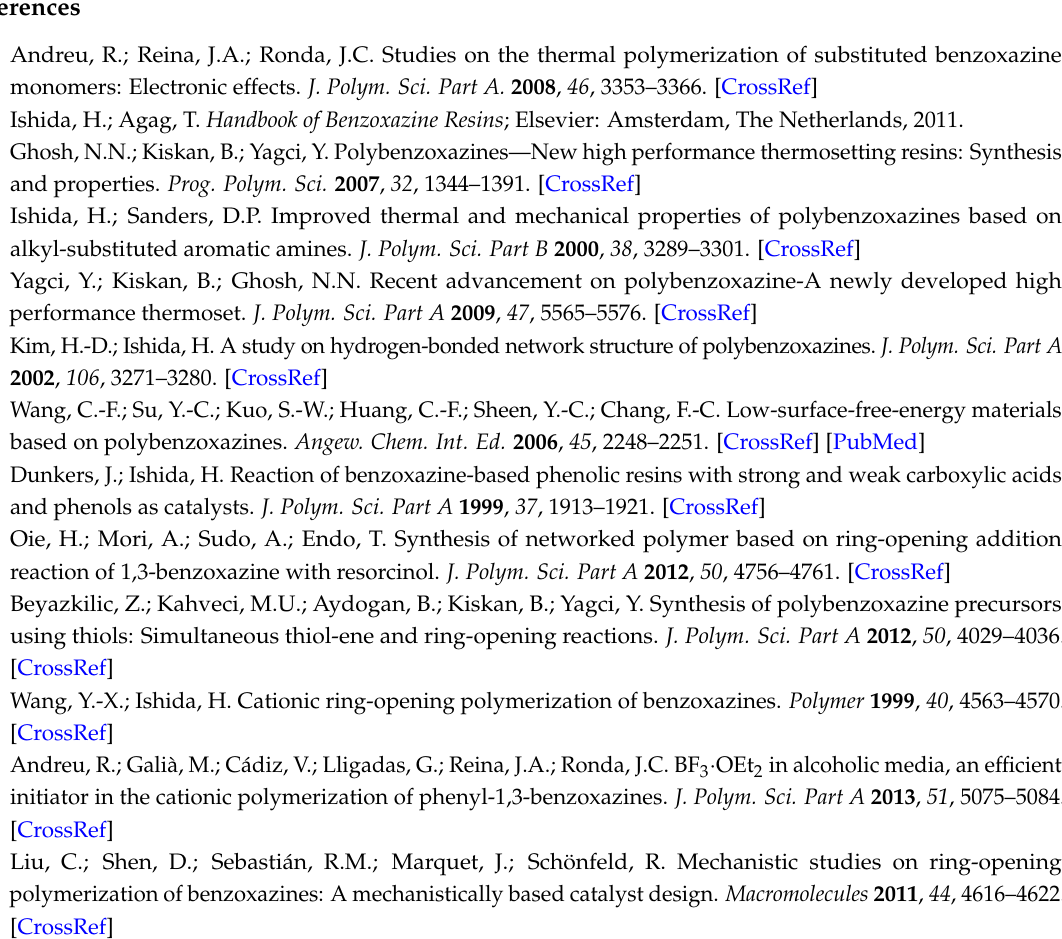
Figure S1: 1 H NMR of P-a; Figure S2: IR(ATR) of P-a; Figure S3: DSC of P-a; Figure S4: 1 H NMR of R-a; Figure S5: IR(ATR) of R-a; Figure S6: DSC of R-a; Figure S7: 1 H NMR of T-a; Figure S8: 13 C NMR of T-a; Figure S9: IR(ATR) of T-a; Figure S10: DSC of T-a; Figure S11: IR of poly(P-a); Figure S12: IR of poly(R-a); Figure S13: IR of poly(T-a); Figure S14: 13 C CP TOSS of poly(P-a); Figure S15: 13 C CP TOSS of poly(R-a); Figure S16: 13 C CP TOSS of poly(T-a). * signals detected in CPTOSS and not in solution 13 C